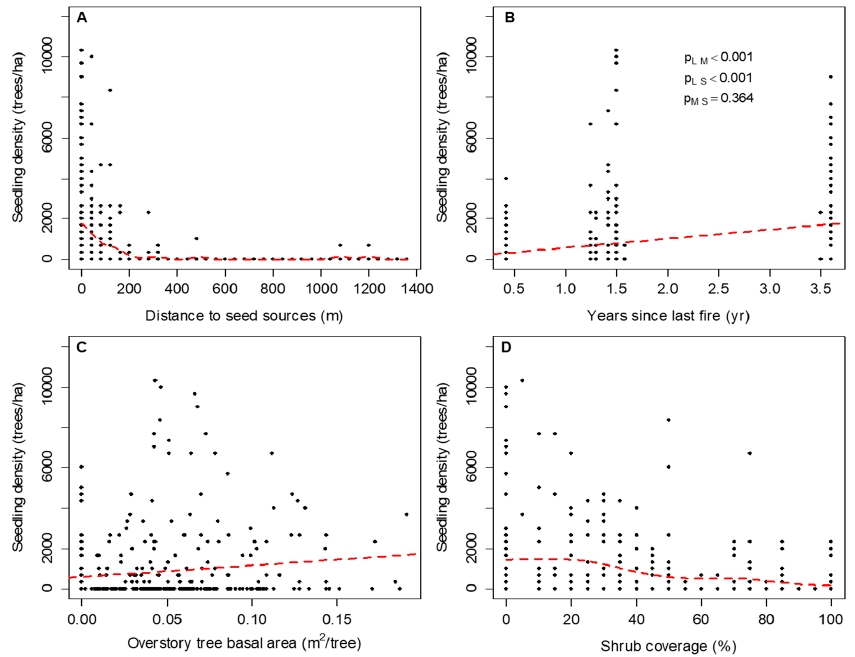
fire return interval ( p < 0.0001). Invaded plots were located significantly closer to roadways and fire lines with a mean distance of 20.3 m in contrast to 167.6 m for the non-invaded plots ( p < 0.001, Figure 6B), and had lower shrub coverage (8.57 ± 3.23% vs. 18.42 ± 2.60%) ( p = 0.025, Figure 6C) and shorter mean fire return interval (2.7 ± 0.17 years vs. 4.3 ± 0.31 years) than non-invaded plots ( p < 0.001, Figure 6D).